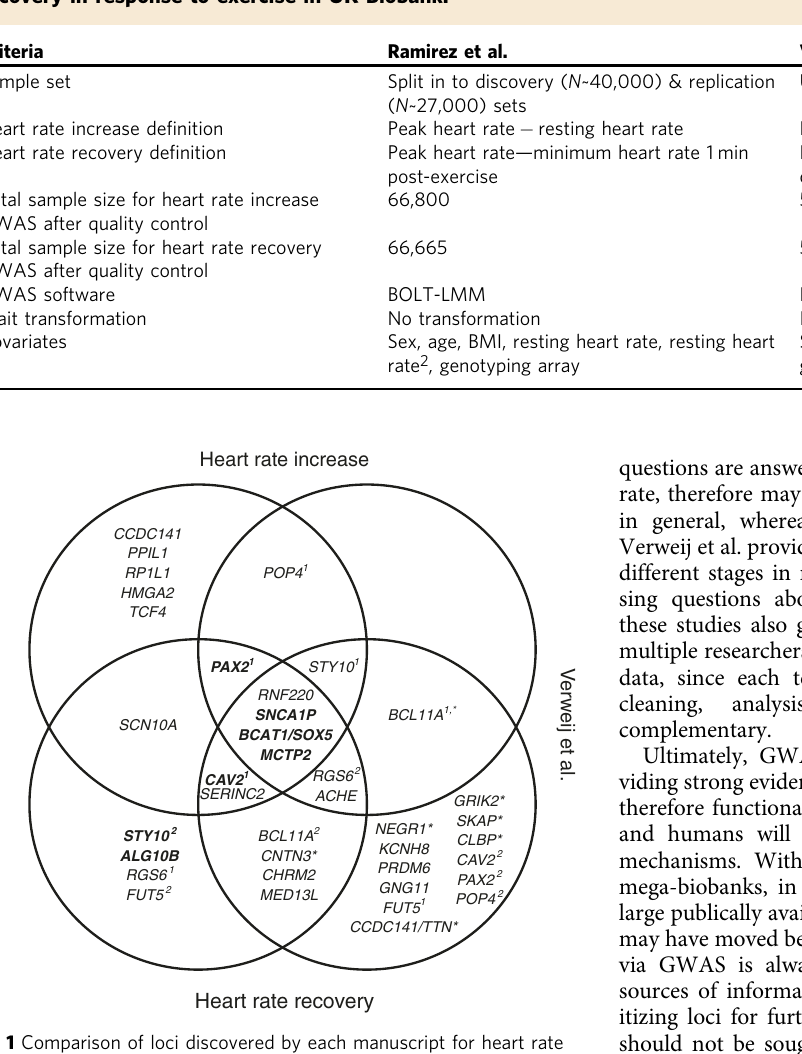
Fig. 1 Comparison of loci discovered by each manuscript for heart rate increase or heart rate recovery in response to exercise. Heart rate increase in both manuscripts was de fi ned in the same way (peak heart rate − resting heart rate). Heart rate recovery in Ramirez et al. was de fi ned as peak heart rate — minimum heart rate 1 min post-exercise. Heart rate recovery in Verweij et al. was de fi ned in the same manner at 10, 20, 30, 40, and 50 s post-exercise using mean ± 3 s. Heart rate recovery at 50 s was used for comparison as it was closest to the method used by Ramirez et al. Due to